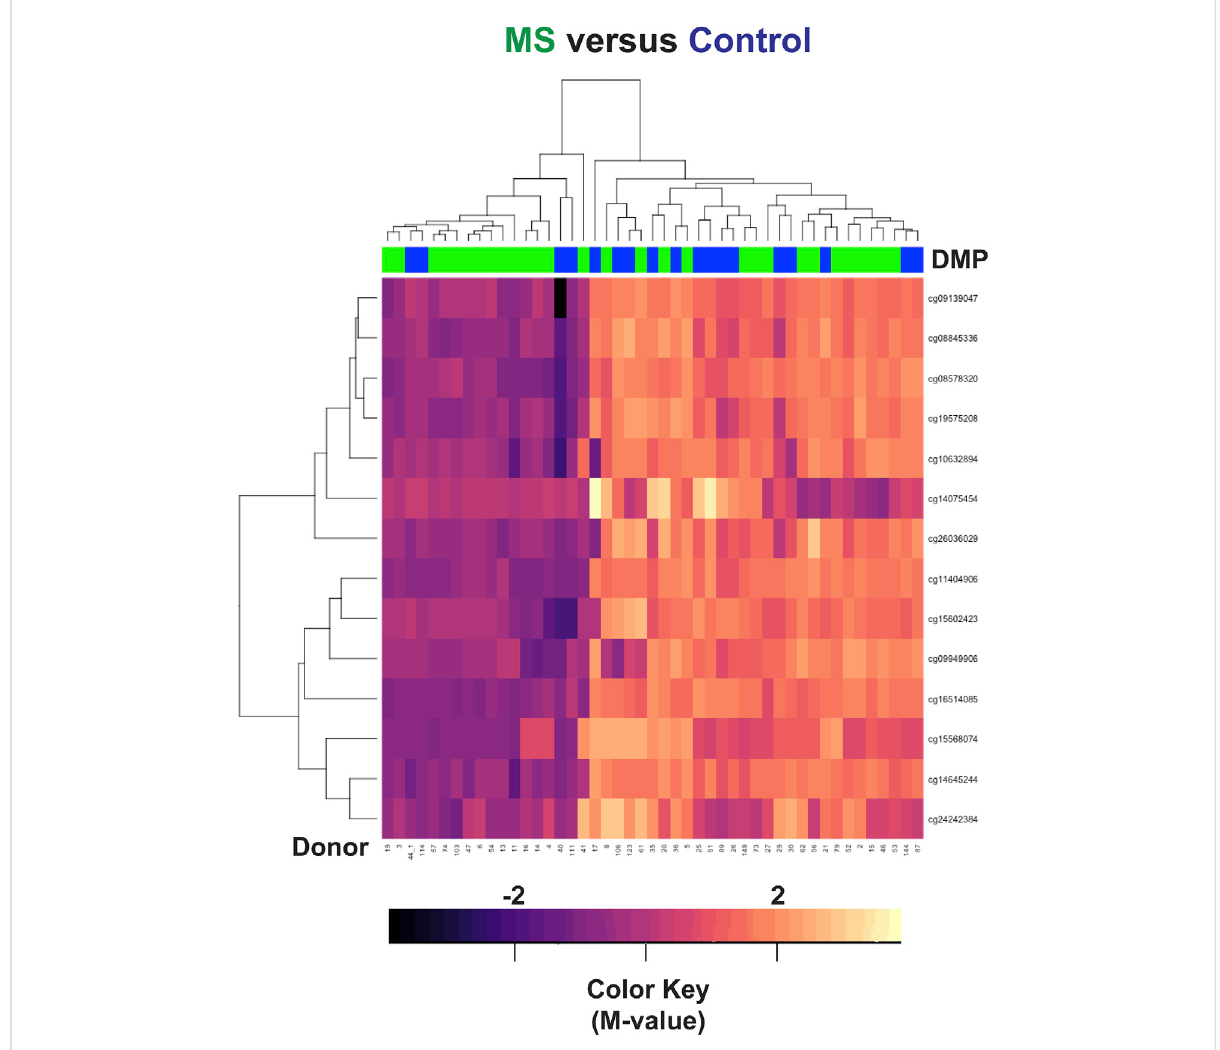
FIGURE 3 Hierarchal clustering analysis of the HLA-DRB1 region. Differences in methylation were observed at 14 CpG regions within HLA-DRB1 but did notnecessarilycorrelatewithdiseasestate.Intheheatmap,MSdonorsaredesignatedbygreen,andcontrolsbyblueatthetopoftheheatmap.Blue/ purple designates relative demethylation and orange/red increased methylation at a speci fi c CpG